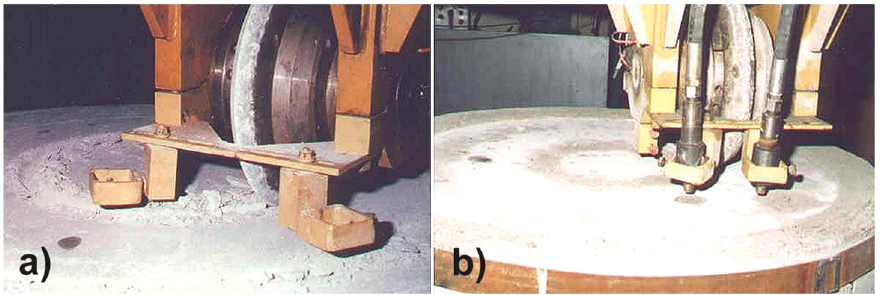
Figure 15. View of the test stand for testing single tools: ( a ) during concrete sample mining using a symmetrical disk tool, ( b ) ready to test with a disk tool assisted by high pressure water jets [1].